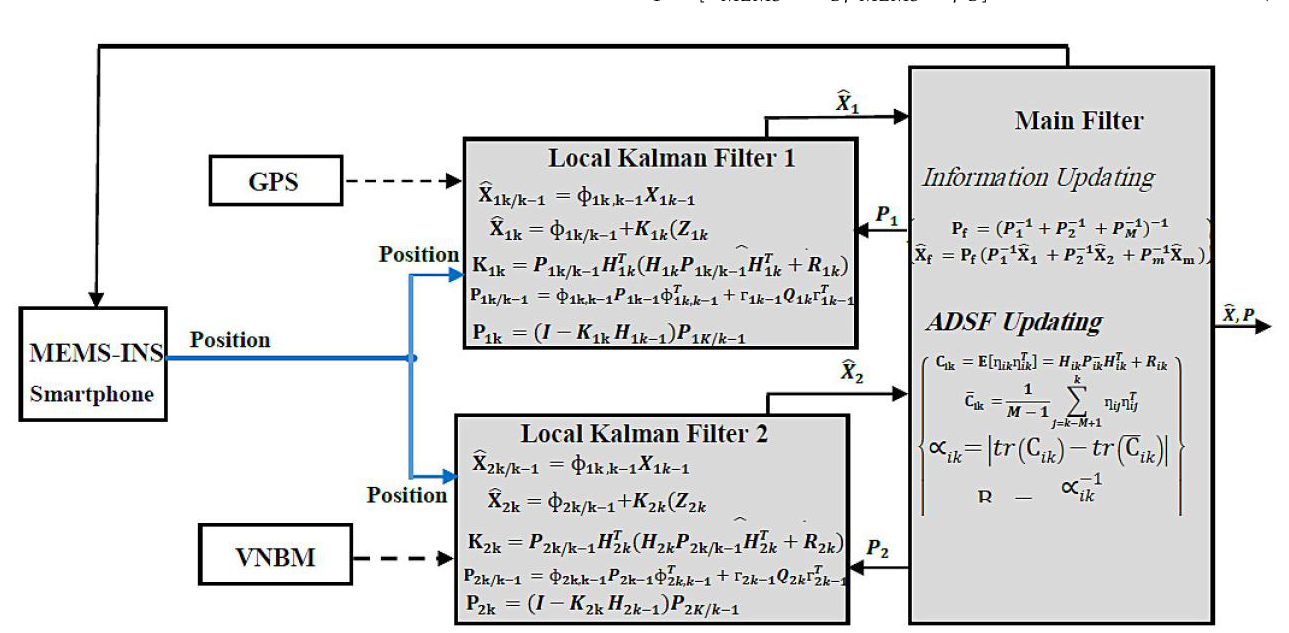
Figure 5. Proposed VNBM/GPS/MEMS – INS integrated method based on adaptive DSF combined filter data fusion.